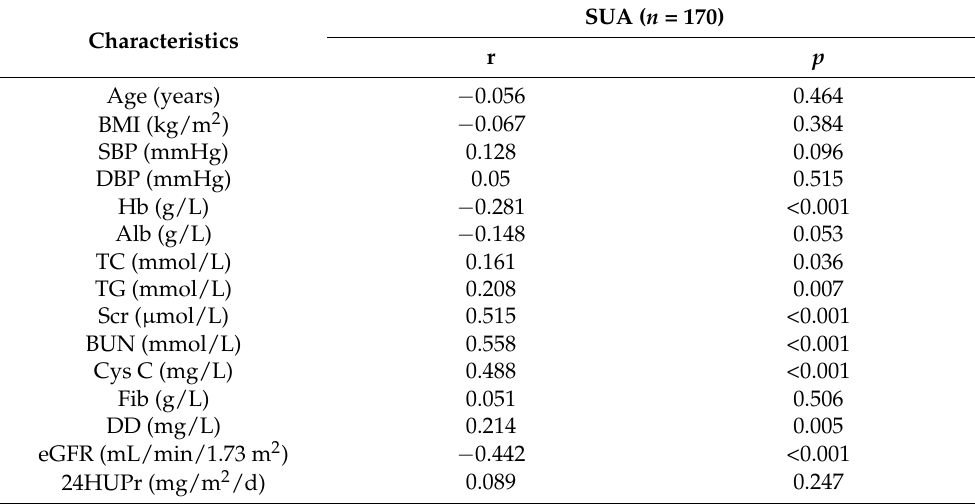
Table 2. Correlations between SUA and associated factors for